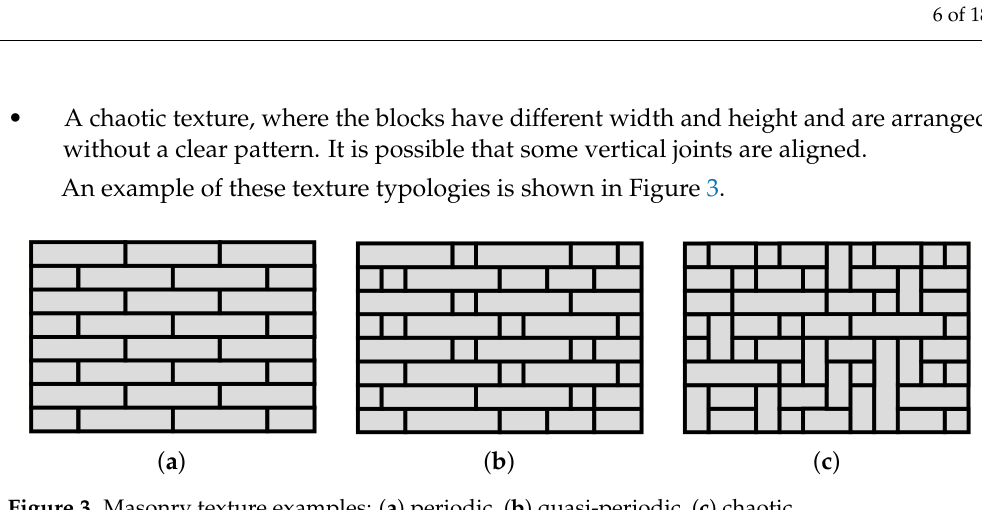
Figure 3. Masonry texture examples: ( a ) periodic, ( b ) quasi-periodic, ( c )